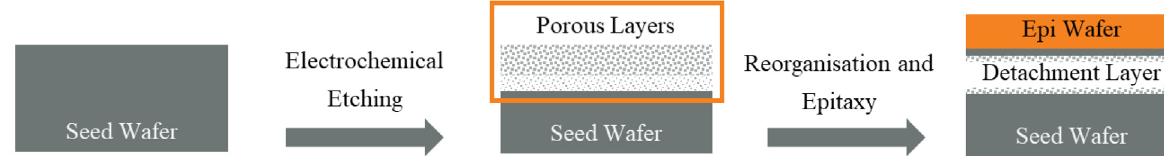
Fig. 1. Schematic depiction of the initial production steps in the epitaxial wafer production process. Our work focuses on the investigation of the porous layers, shown in